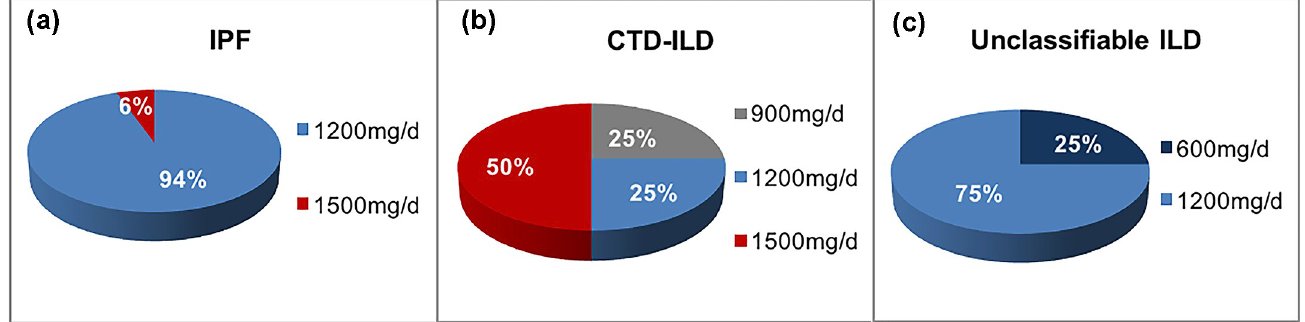
Fig 4. Dose reduced after adverse drug events occurred in three